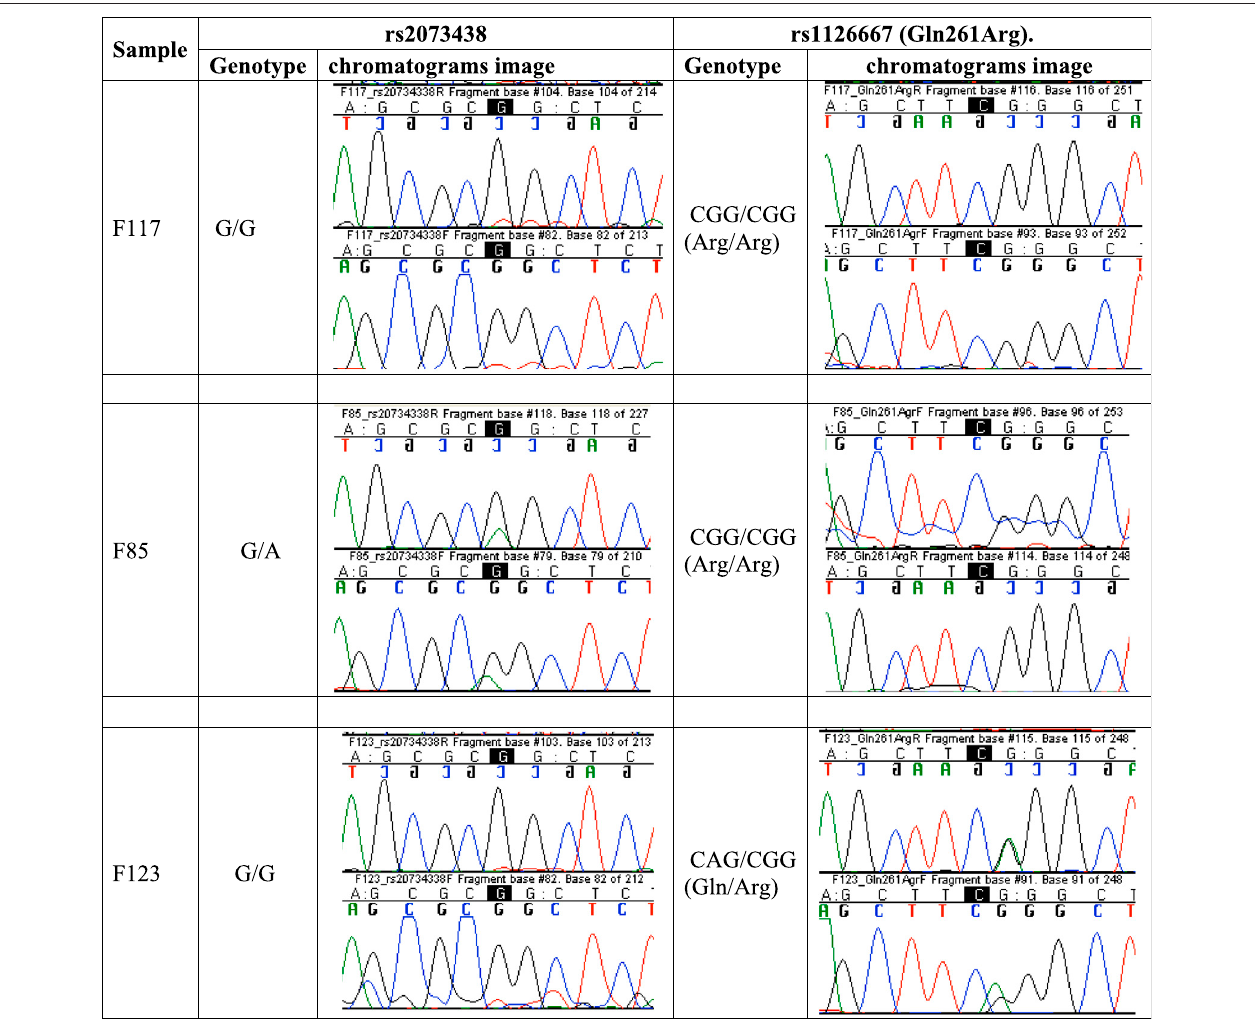
FIGURE 5 | Chromatogram images showing results of DNA sequencing to determine the genotypes at SNPs rs2073438 and rs1126667 of ALOX12 gene. Participant F117 is homozygous G/G at rs2073438 and homozygous CGG/CGG at rs1126667, F85 is heterozygous G/A at rs2073438, and F123 heterozygous CAG/ CGGatrs1126667.DNA sequencing results forallparticipants areaccessible athttps://www.frontiersin.org/articles/10.3389/fgeed.2021.722190/full#supplementary- material.